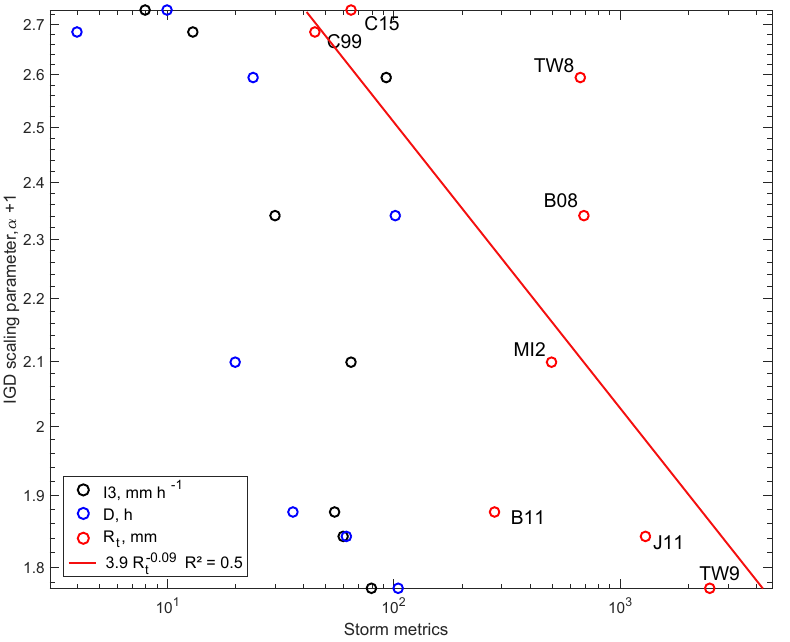
Figure 7. Landslide scar size distribution decay exponents against storm total rainfall (red), storm duration (blue) and storm peak intensity (black). The best least-squares fit is shown in red. The reduction of the decay exponents with increasing storm magnitude indicates an increase in the proportion of large landslides relative to small